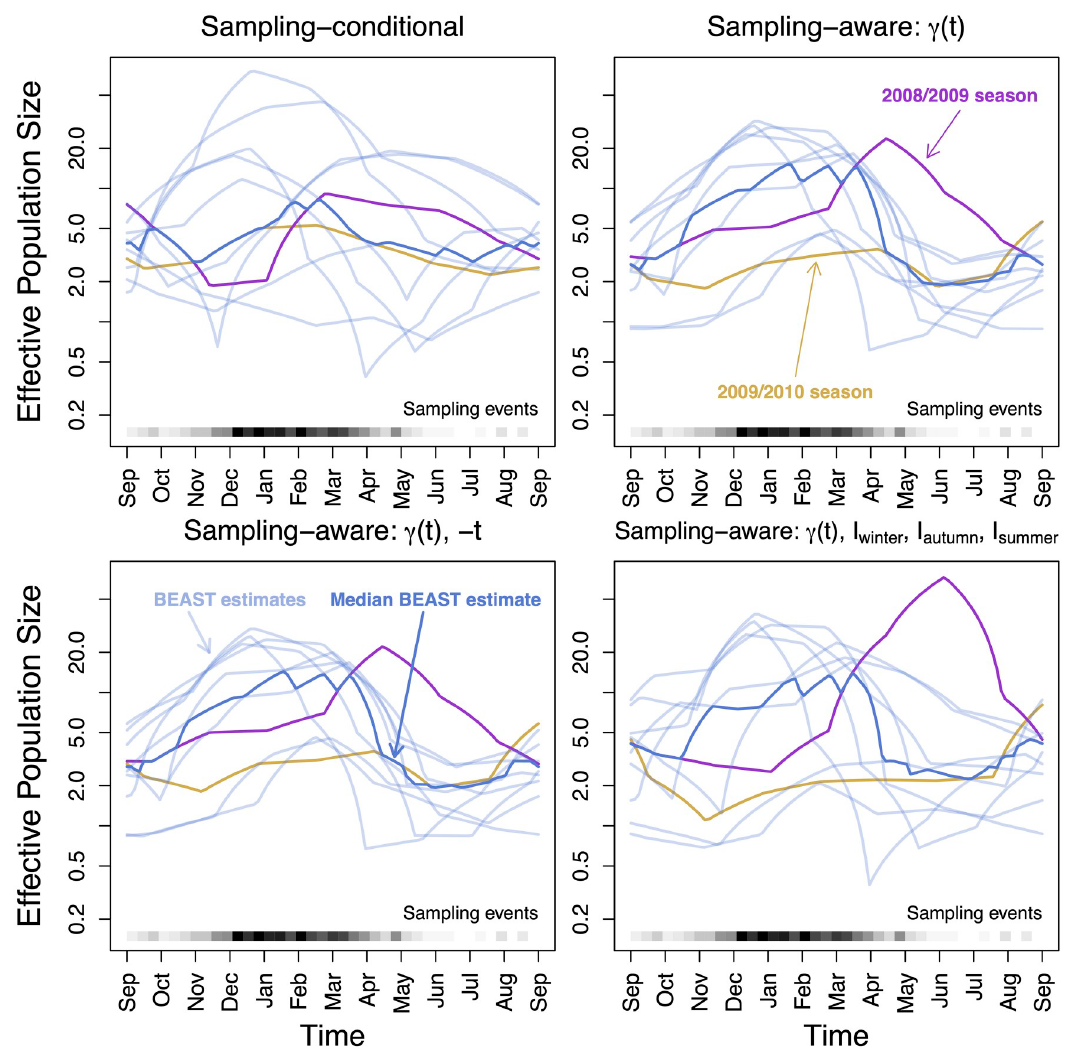
Fig 6. Effective population size seasonal overlay for the USA and Canada influenza dataset. The light blue lines are the pointwise posterior estimates for each year, and the dark blue line is the median annual estimate. Upper left : Sampling-conditional posterior. Upper right : Sampling-aware posterior with only log-effective population size γ ( t ) informing the sampling time model. Lower left : Sampling- and covariate-aware posterior, with γ ( t ) and − t . Lower right : Sampling- and covariate-aware posterior, with γ ( t ) and seasonal indicators I winter , I autumn , I summer